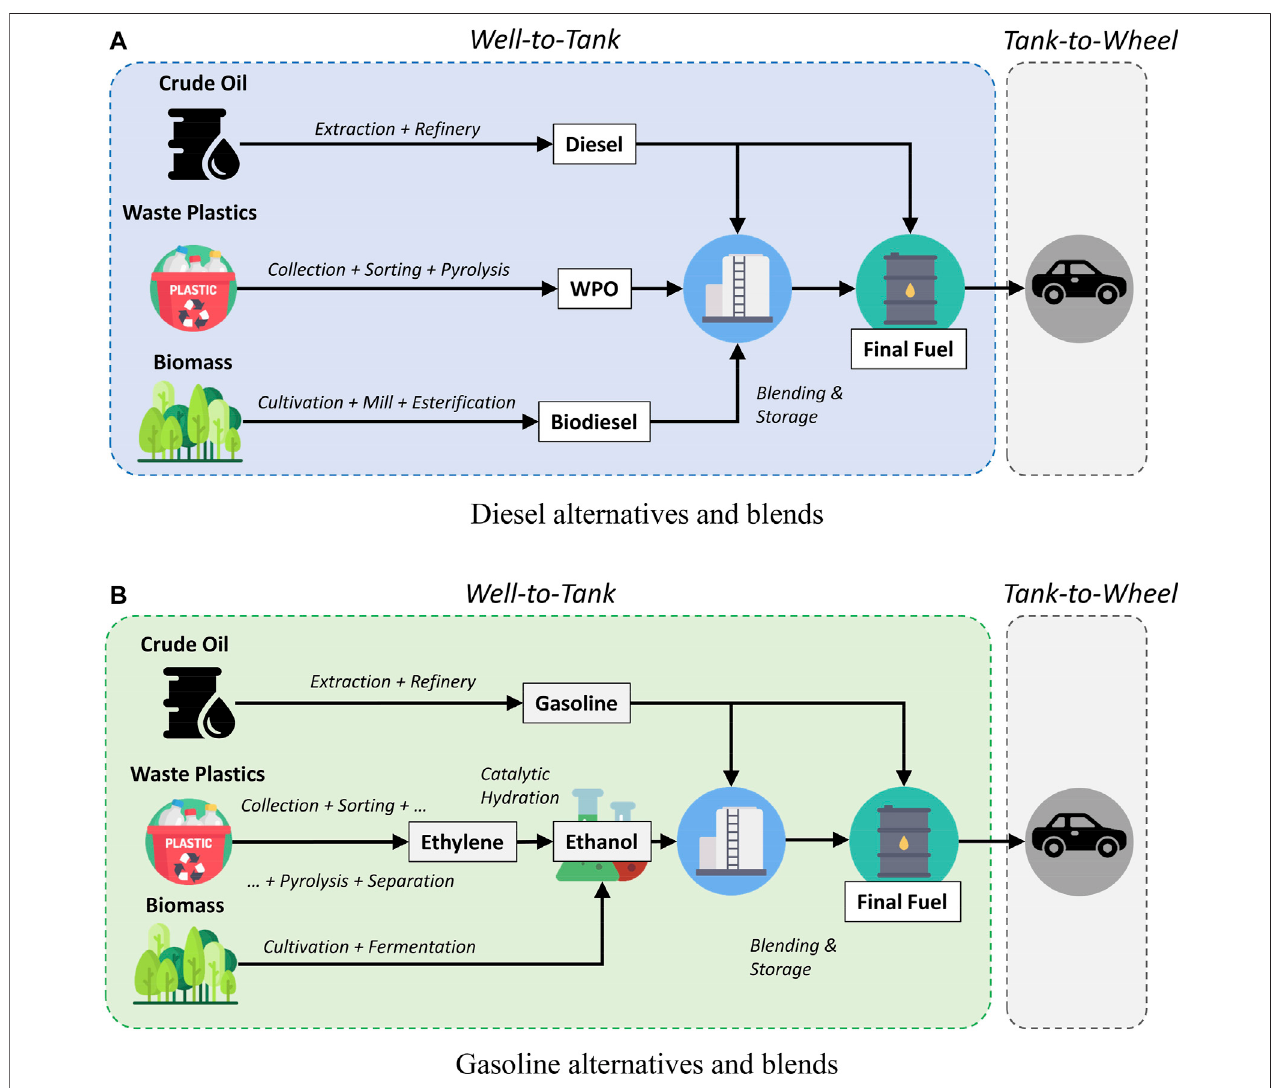
FIGURE 1 | Scope of investigation for the production pathways to (A) diesel and (B)